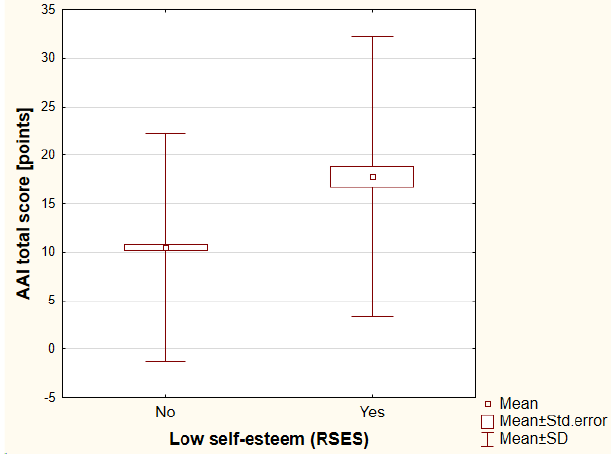
Figure 4. The differences in COPS total score between individuals with low self-esteem versus high self-esteem. AAI — the Appearance Anxiety Inventory, RSES — the Rosenberg Self Esteem Scale, SD — standard deviation.